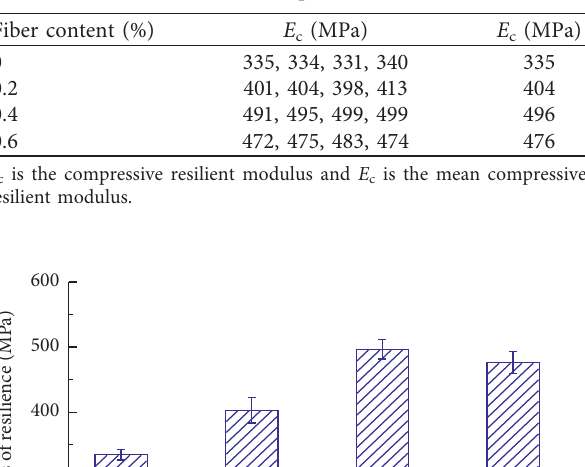
Table 8: Uniaxial compression test results.